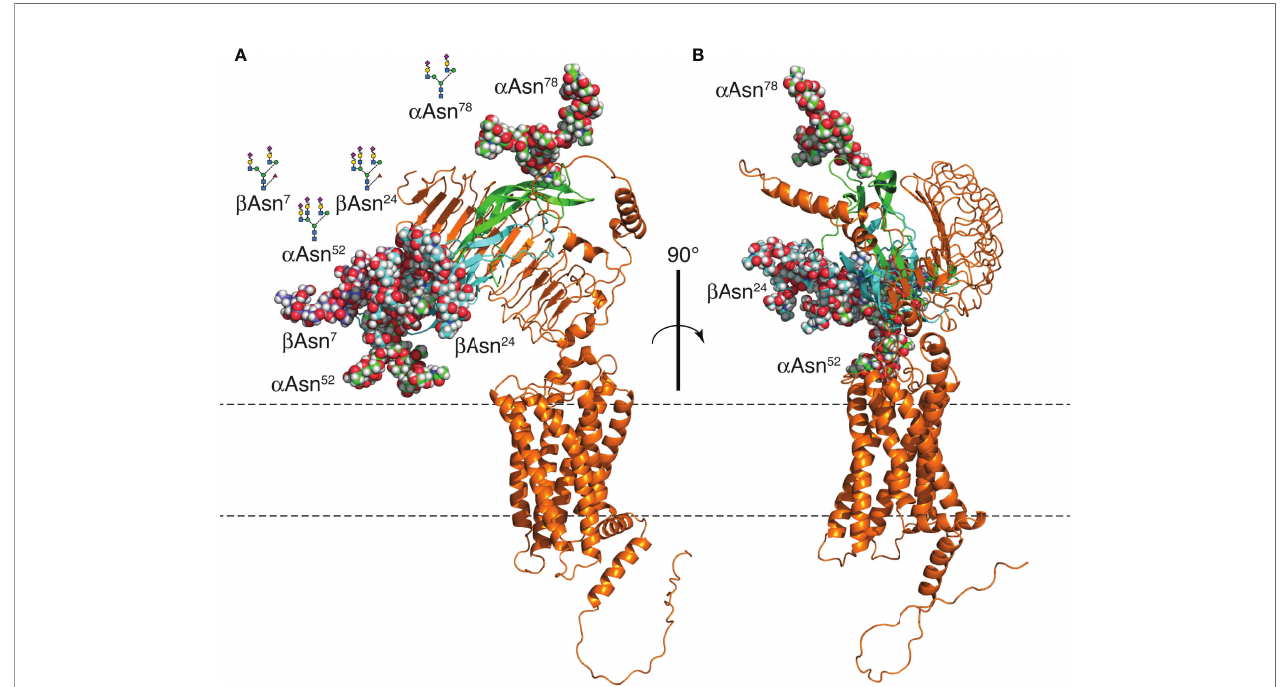
FIGURE 11 | FSH24/FSHR model. (A) Models of FSH24 and FSHR associated based on the crystal structure of FSH-FSHR ECD (4AY9). The FSH a subunit cartoon is shown in green and FSH b in cyan. Oligosaccharides are rendered as spheres. FSH b Asn 7 glycan is colored dark blue to distinguish it from the cyan-colored Asn 24 glycan. Each glycan represents the most abundant glycan structure at a Asn 52 , a Asn 78 , and b Asn 7 ( Table 2 ) with a tri-antennary glycan chosen for b Asn 24 . Three glycans are clustered at one end, while the a Asn 78 glycan is at the opposite end. (B) Figure rotated 90° to emphasize the FSH peptide moiety is sandwiched between the FSH glycans and the FSHR. Oligosaccharide models created and attached to an FSH model extracted from pdb fi le 4AY9 using the web-based Glycam glycoprotein builder tool [Woods Group. (2005-2016) GLYCAM Web. Complex Carbohydrate Research Center, University of Georgia, Athens, GA.